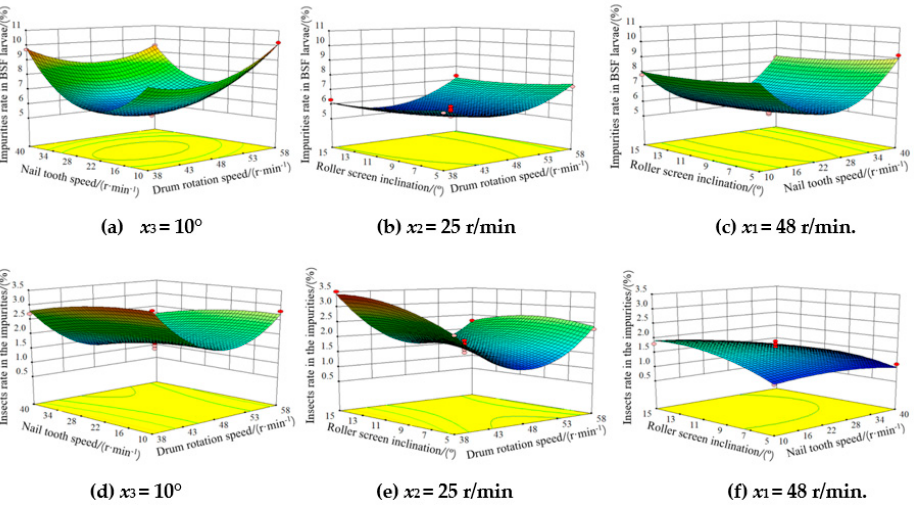
Figure 12. Effects of various factors on the membrane impurity separation performance.